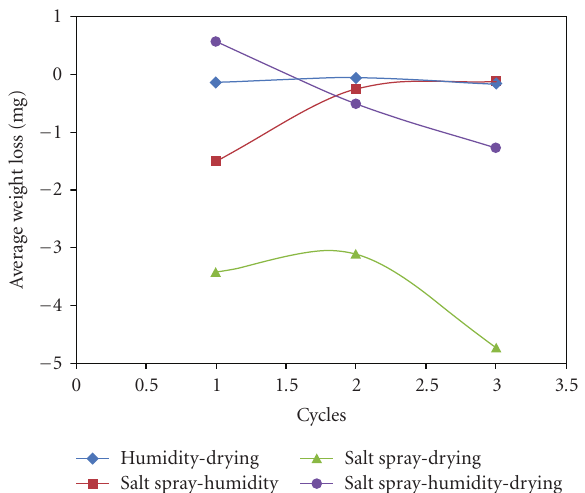
Figure 2: Average weight loss of the AE44 coupons arranged by test condition based on cycle number. Note the straight line of the humidity-drying test condition.